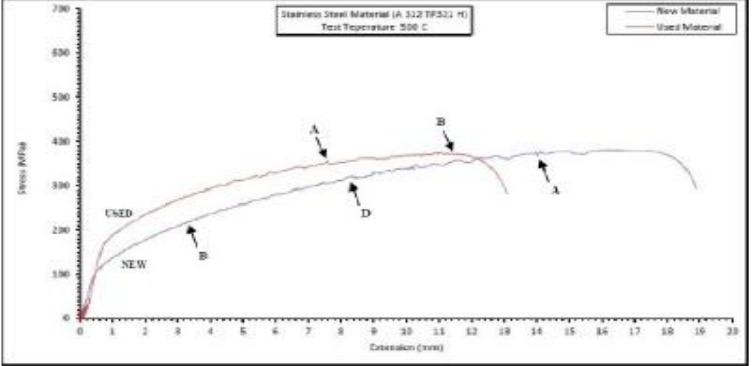
Fig. 11 Stress-strain curve at 500 o C temperature for un-used and ex-used stainless steel